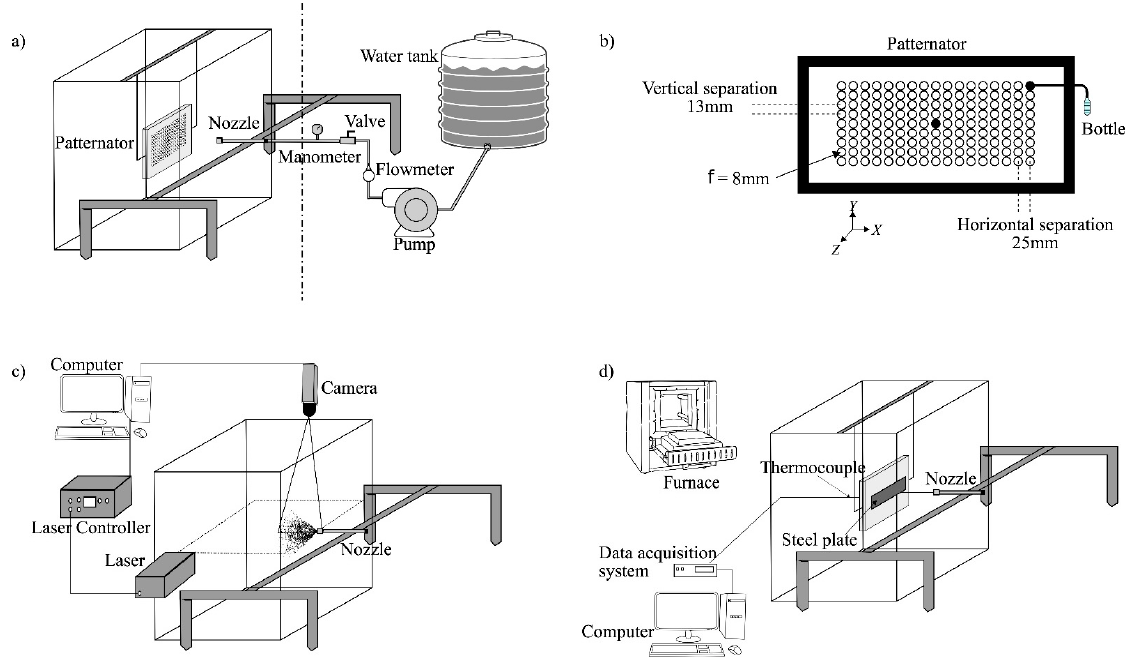
Figure 1. ( a ) Experimental setup to impingement density measurements, ( b ) collector dimensions, ( c ) experimental setup to characterize the water jet and ( d ) experimental setup to heat fluxes esti- mations. Table 1. Experimental conditions for impingement density.